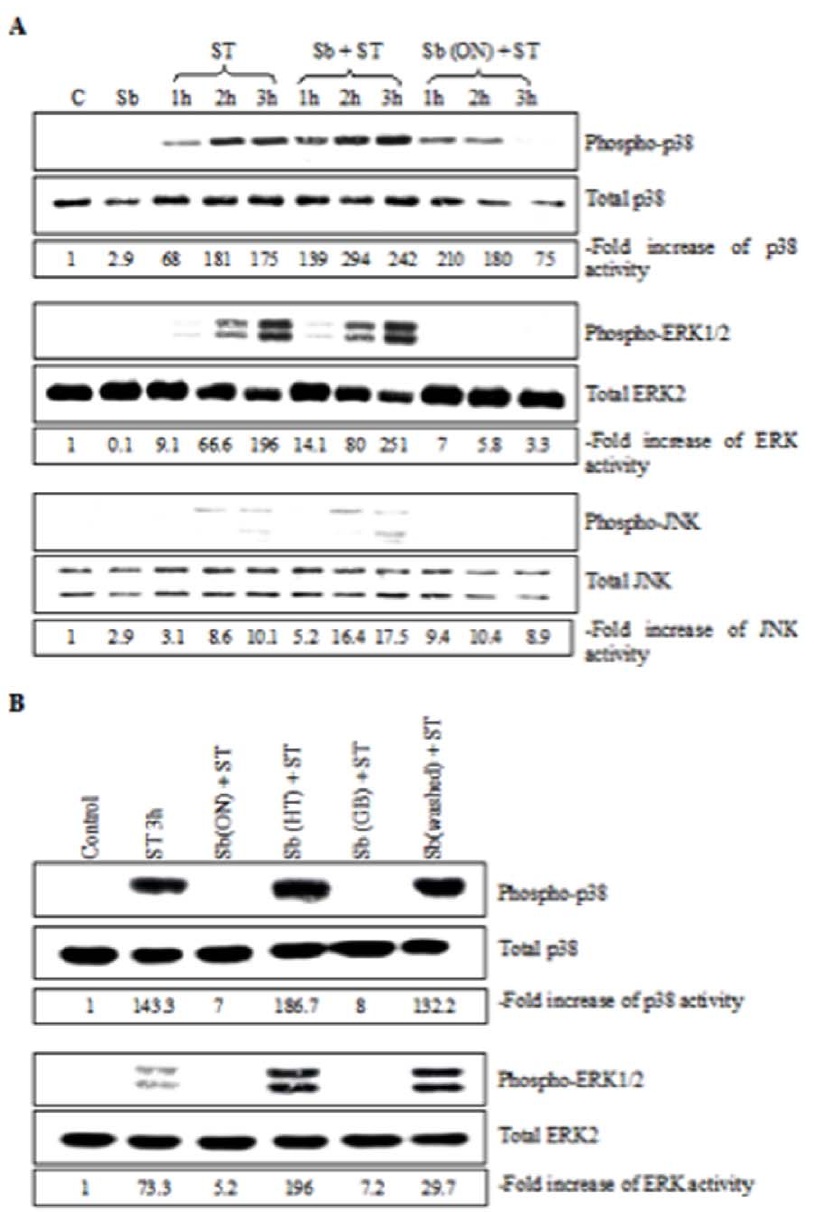
Figure 9. S.boulardii influences S. Typhimurium-induced MAPK activation (A). (B) Effect of S. boulardii (Sb ON), Sb heat treated (Sb HT), Sb glass beads treated (Sb GB), and Sb PBS washed (Sb washed) on MAPK (p-38 and ERK1/2) activation induced by ST in infected T84 cells. Cells were lysed at indicated times after infection. Samples were resolved by SDS-PAGE and analyzed by immunoblotting with anti-phospho-ERK1/2, anti- phospho-p38, and anti-phospho-JNK antibodies. Total ERK, p38 and JNK are shown as loading controls. Control lanes correspond to uninfected T84 cells and T84 cells with Sb. ON, overnight. (C) Samples were resolved by SDS-PAGE and analyzed by immunoblotting with anti-phospho-I k B or anti- I k B antibodies. The control lane corresponds to uninfected T84 cells. Densitometry was performed using Image J software [33]. Western blots shown here are representative of 5 independent experiments.